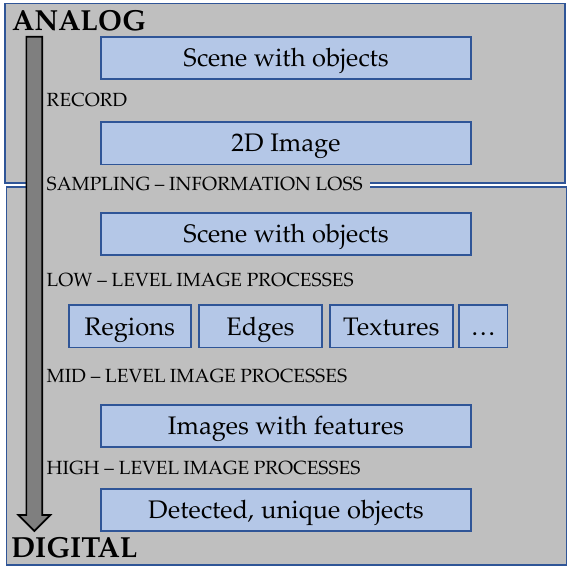
Figure 3. The theoretical levels of image representation for image analysis. The transformation from the analog to the digital domain (with sampling) always results in some information